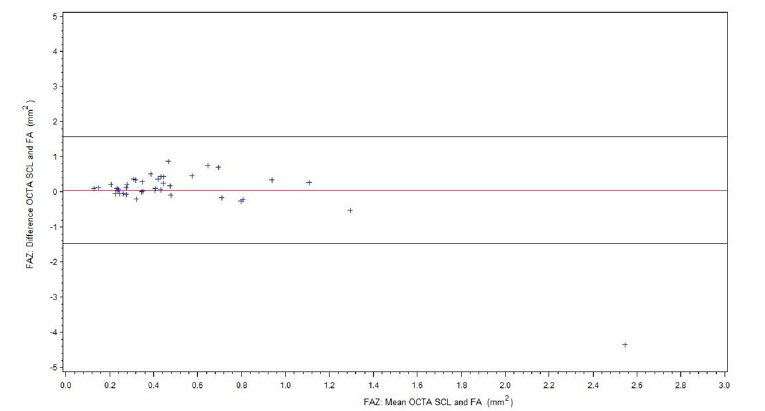
Fig 7. FAZ: Bland-Altman-Plot for the agreement of FA and OCTA SCL in patients with ME.